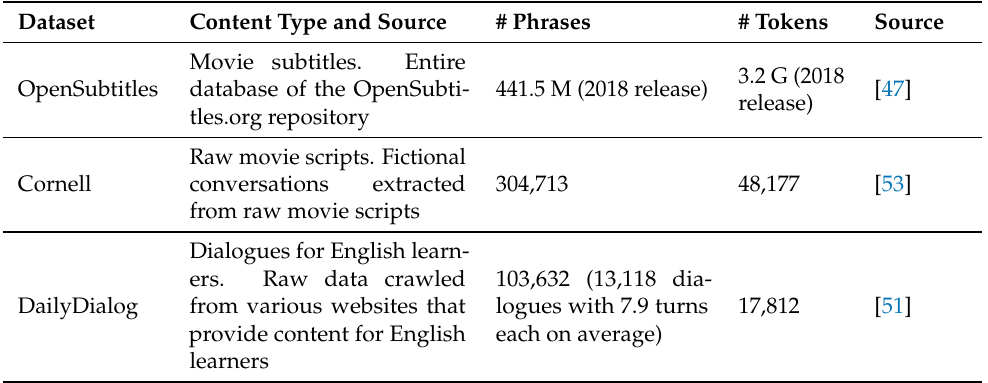
Table 2. Summary of chatbot